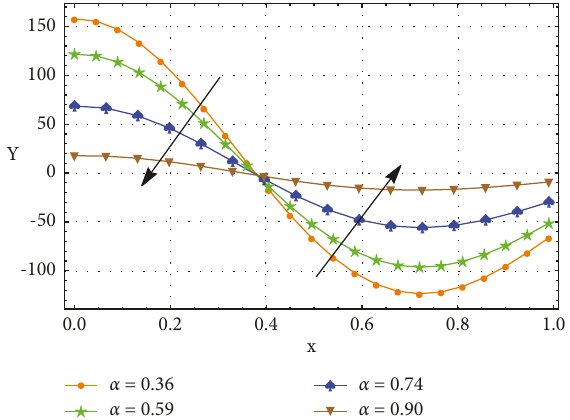
Figure 2: Effect of α on wave profile in Example 1, when ρ � σ � ] � 1 and τ �